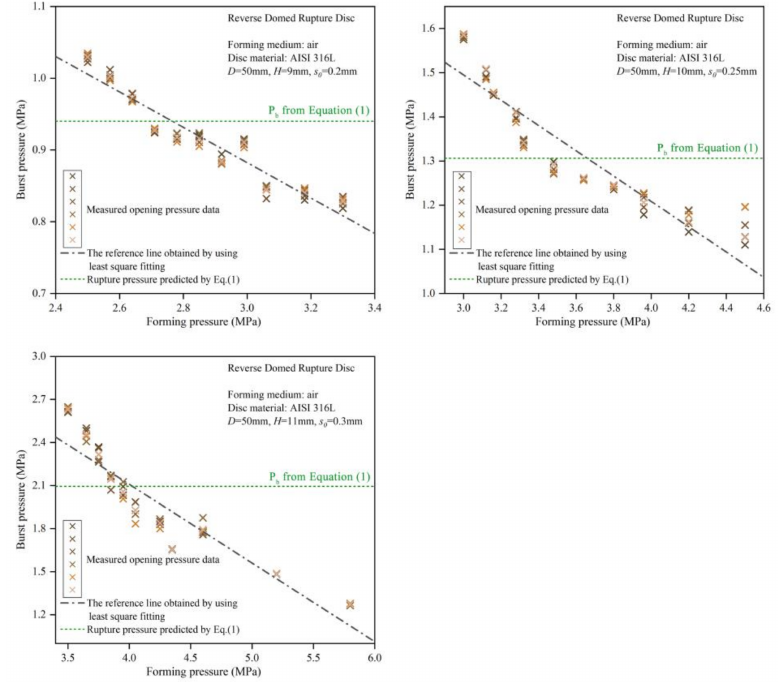
Figure 9. For the pneumatic forming method, the relationship between the burst pressure and the forming pressure of rupture discs with a diameter of 50